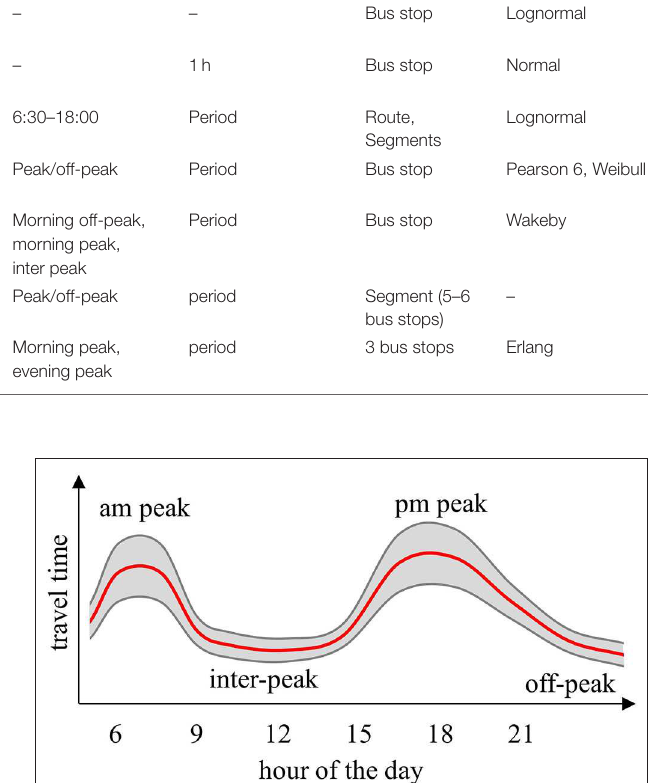
Mazloumi et al. (2010) investigated the effects of the temporal aggregation of bus travel time data by aggregating the data into departure time windows (DTWs). This allowed them to examine the travel time distributions for DTWs at different times of the day. Their study showed that for narrow DTWs, travel time distributions are best characterized by normal distributions, while for wide DTWs, peak-hour travel times are well-represented by normal distributions, and off-peak